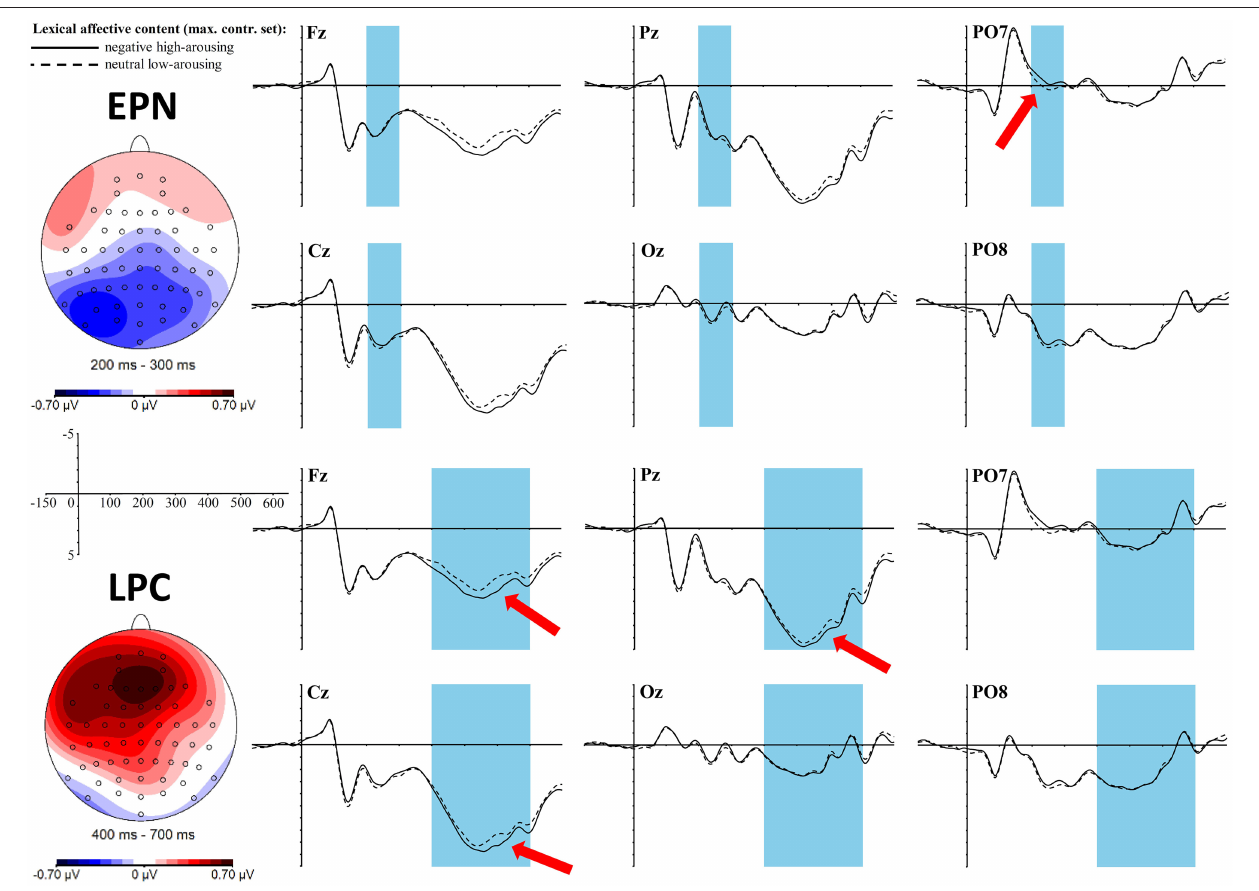
FIGURE 4 | ERP effects of the lexical affective content (top: EPN, bottom: LPC) in the maximally controlled stimulus set at selected electrode sites. The red arrows indicate at which electrodes the effects are most pronounced. For the topographic maps neutral low-arousing words were subtracted from negative high-arousing